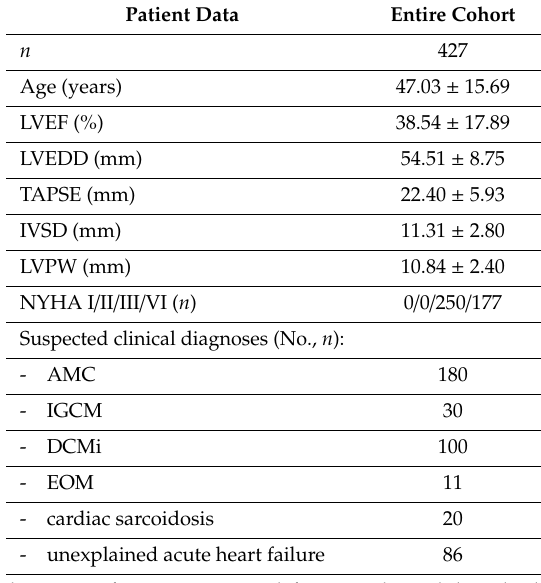
Table 2. Patients’ Characteristics, Hemodynamic Data and Suspected Clinical Diagnoses within the Entire Study Group.